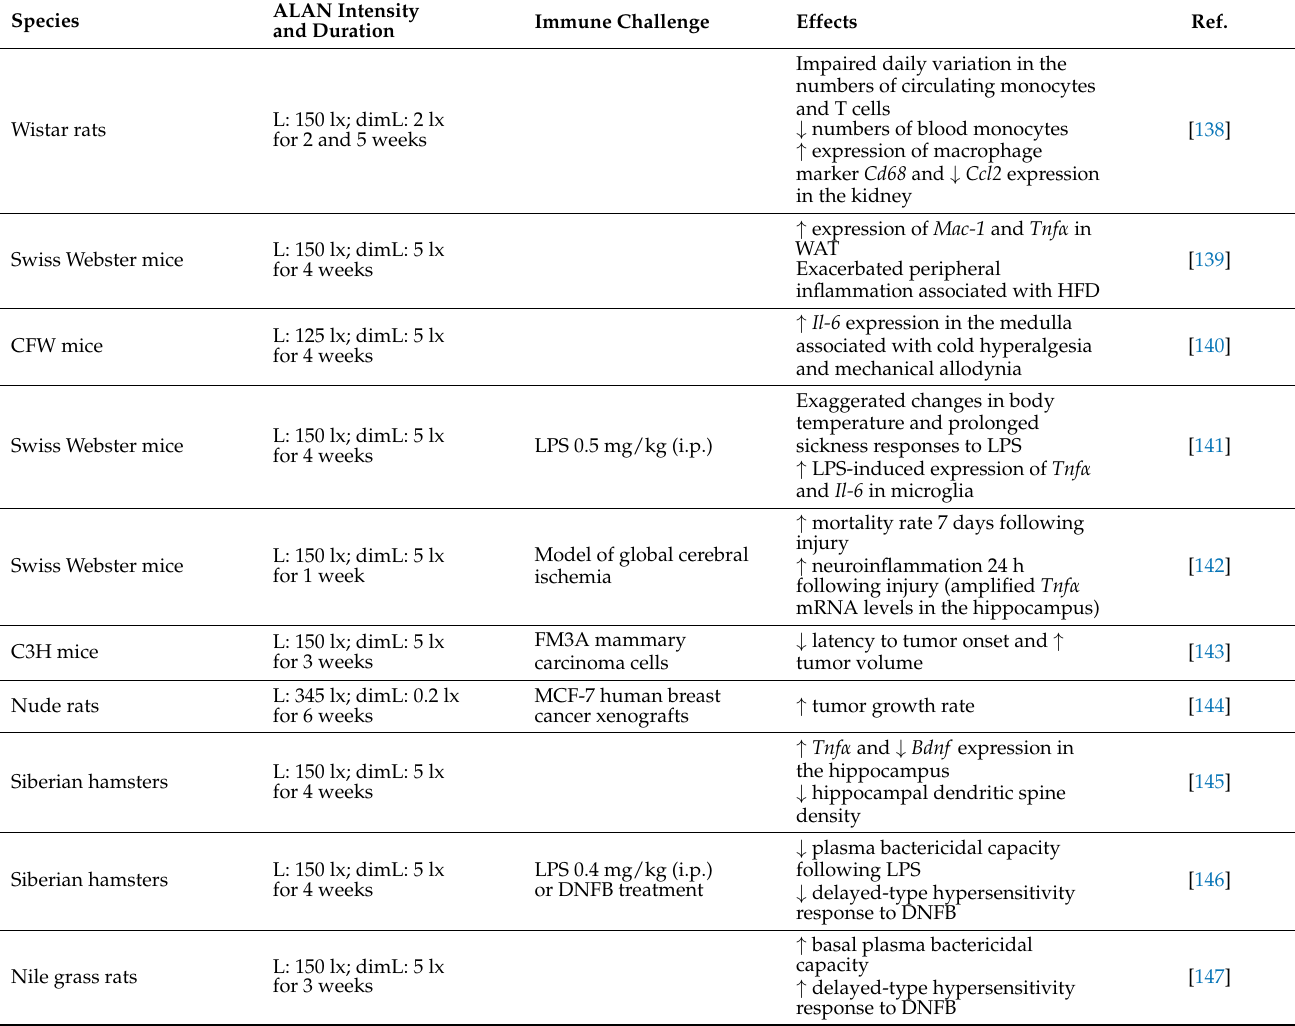
Table 3. Summary of the effects of dim artificial light at night (ALAN) on the immune parameters under steady state and challenged conditions in